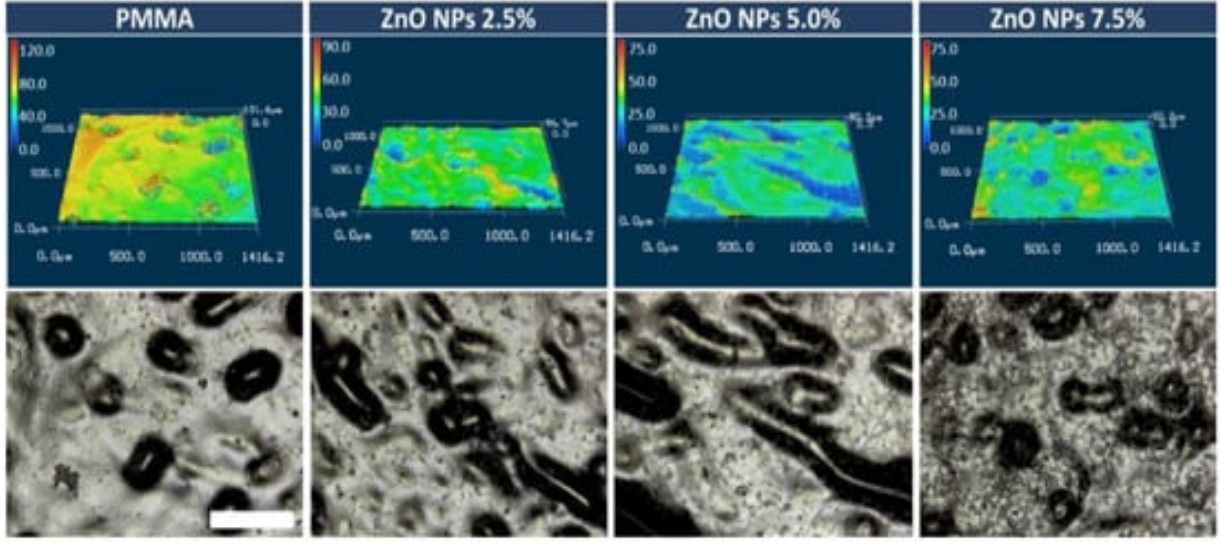
Figure 7. Surface topography of PMMA/ZnO nanocomposites: 3D laser microscope images ( top ) and optical laser-enhanced images ( bottom ). The scale bar (white) refers to 400 µm and it is applicable to all images. Reprinted from ref. [105], copyright 2018, MDPI.